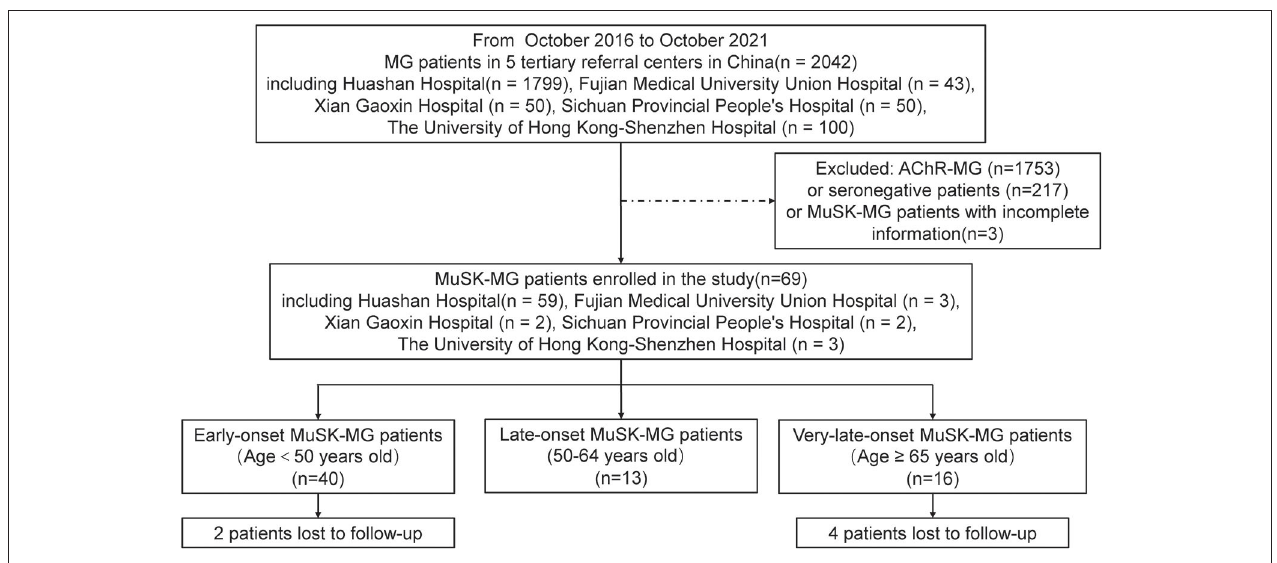
FIGURE 1 | Flowchart for the process of patient